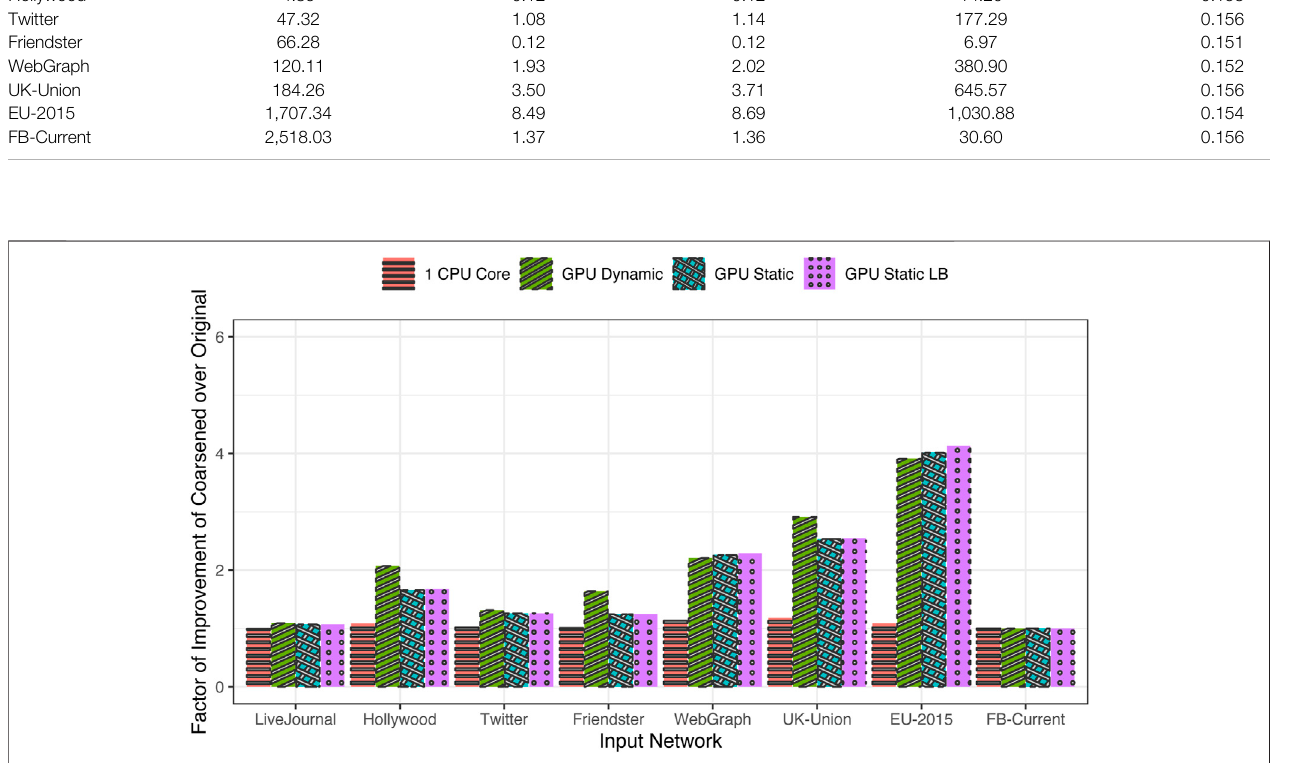
FIGURE 8 | Factor of improvement in run time using coarsened versus original distribution.